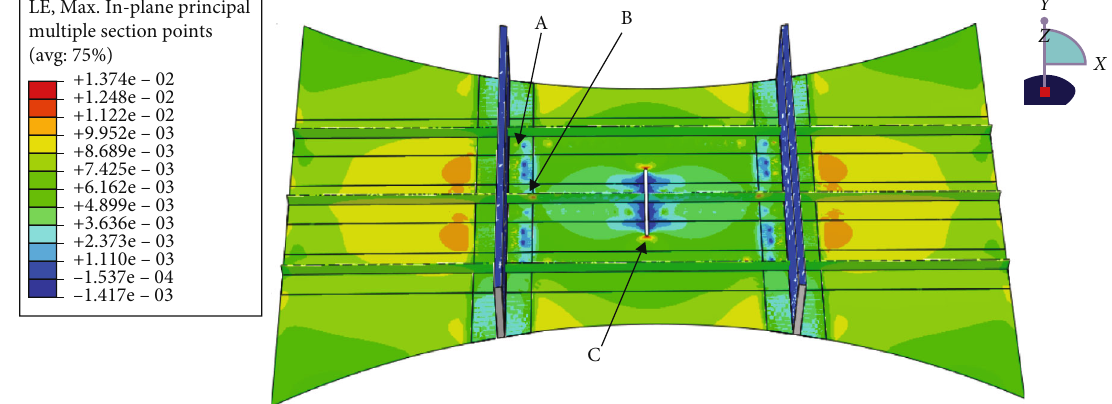
Figure 23: UMAT analysis repaired panel maximum in-plane principal strain (the repair panels are